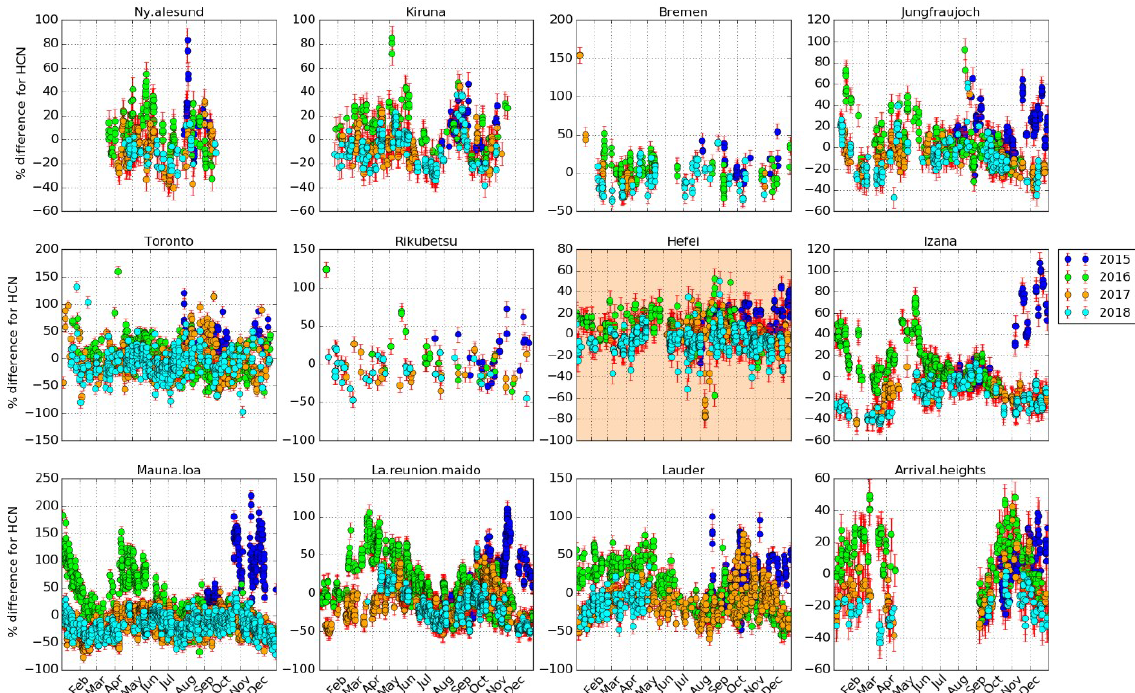
Figure 4. Fractional difference in the partial columns (surface–15km) of HCN from 2015 to 2018 at Ny-Ålesund, Kiruna, Bremen, Jungfrau- joch, Toronto, Rikubetsu, Hefei, Izana, Mauna Loa, La Reunion Maido, Lauder, and Arrival Heights relative to their seasonal mean values. Vertical error bars represent the estimated retrieval errors. All stations are organized as a function of decreasing latitude.